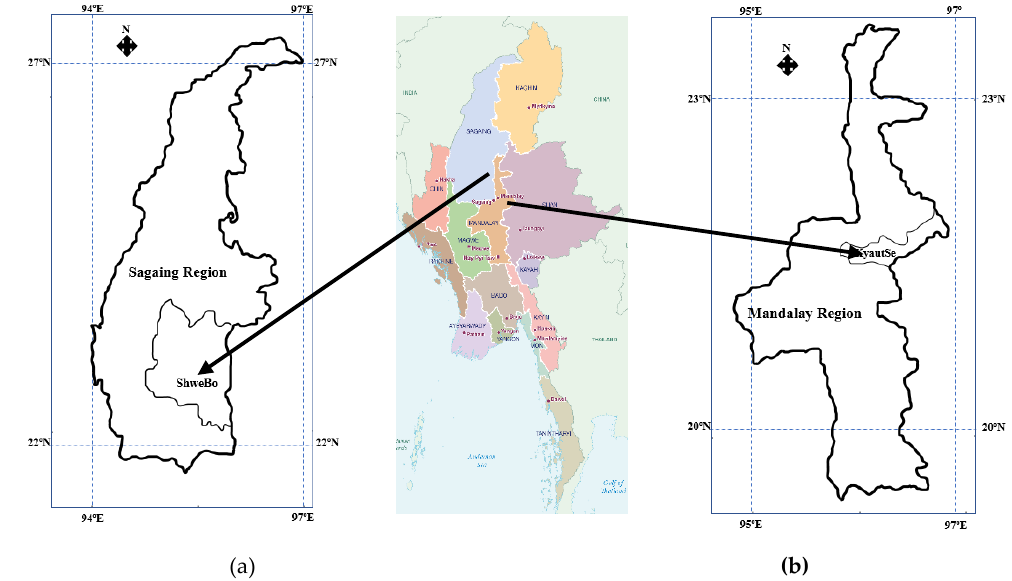
Figure 1. Study area map: ( a ) ShweBo Township in Sagaing region and ( b ) KyautSe Township in Mandalay region, Myanmar.